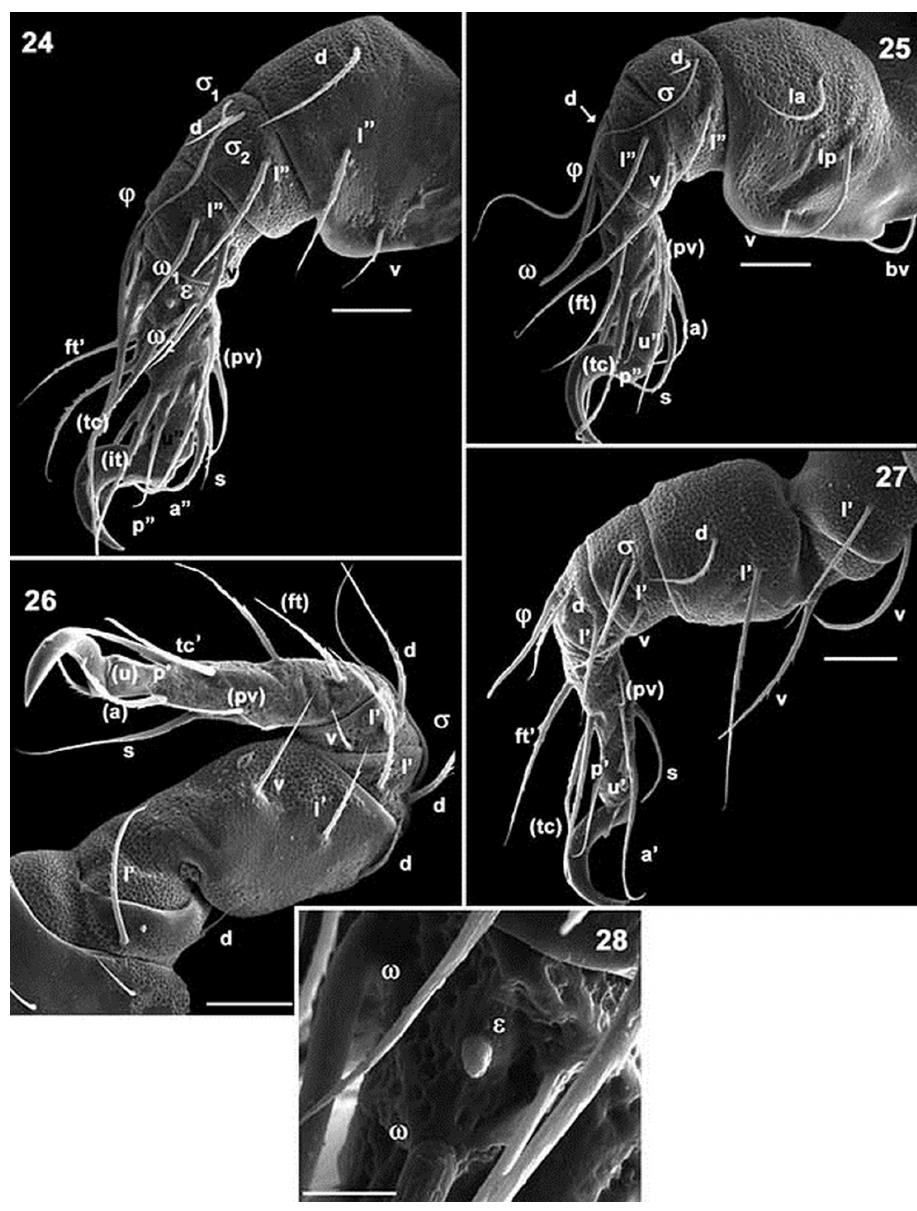
Figures 24–28. Mixacarus turialbaiensis sp. n. Adult with cerotegumental layer. SEM. 24 leg I antiaxial view 25 leg II antiaxial view 26 leg IV antiaxial view 27 leg III antiaxial view 28 tarsus I, famulus zone. Abbreviations: See Material and methods. Scale bar: 23 = 50 μm; 24 = 20 μm; 25 = 20 μm; 26 = 20 μm; 27 = 20 μm; 28 = 5